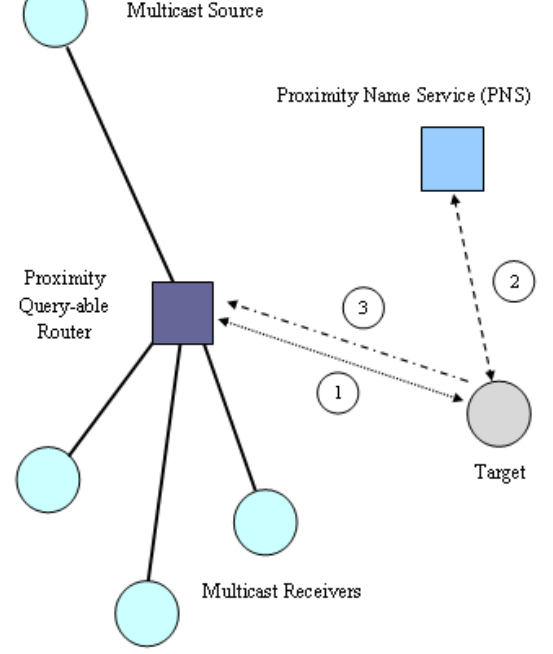
Figure 3. Query steps of the proximity discovery